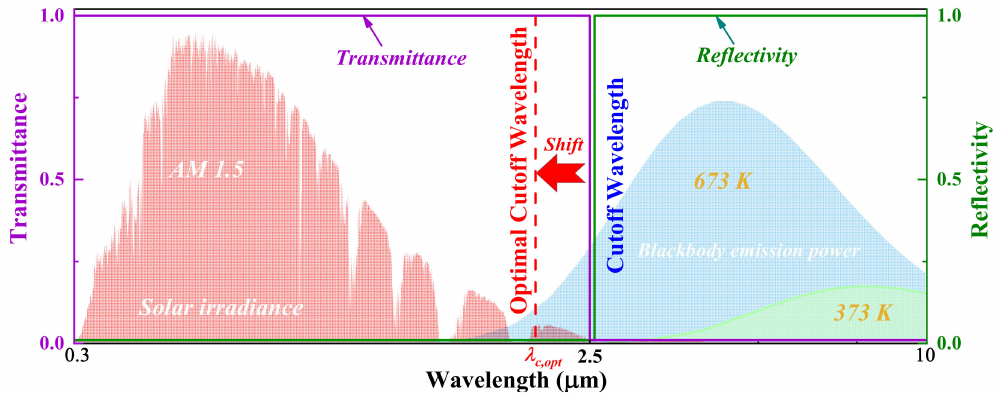
Figure 2. The selectivity characteristics of ideal IR-reflector coating.